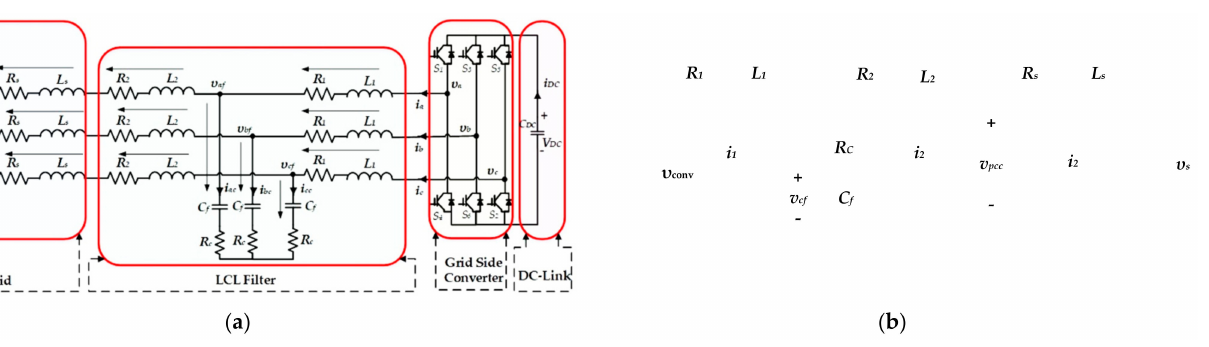
Figure 5. ( a ) A three-phase, two–level VSC with an LCL filter and ( b ) a single–phase LCL filter equivalent